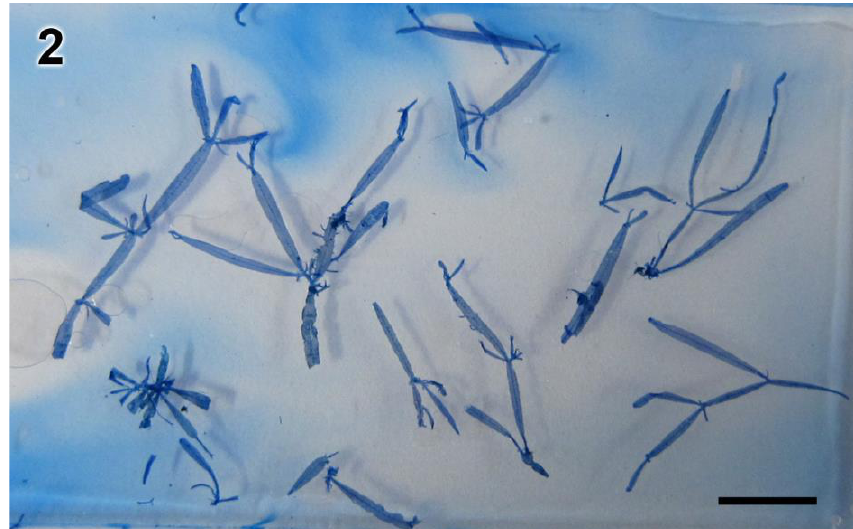
Figure 2. Caloglossa kamiyana sp. nov., holotype specimen from sample “ RR ” , collected from a West Indian manatee in Crystal River, FL, USA, scale = 4 mm.